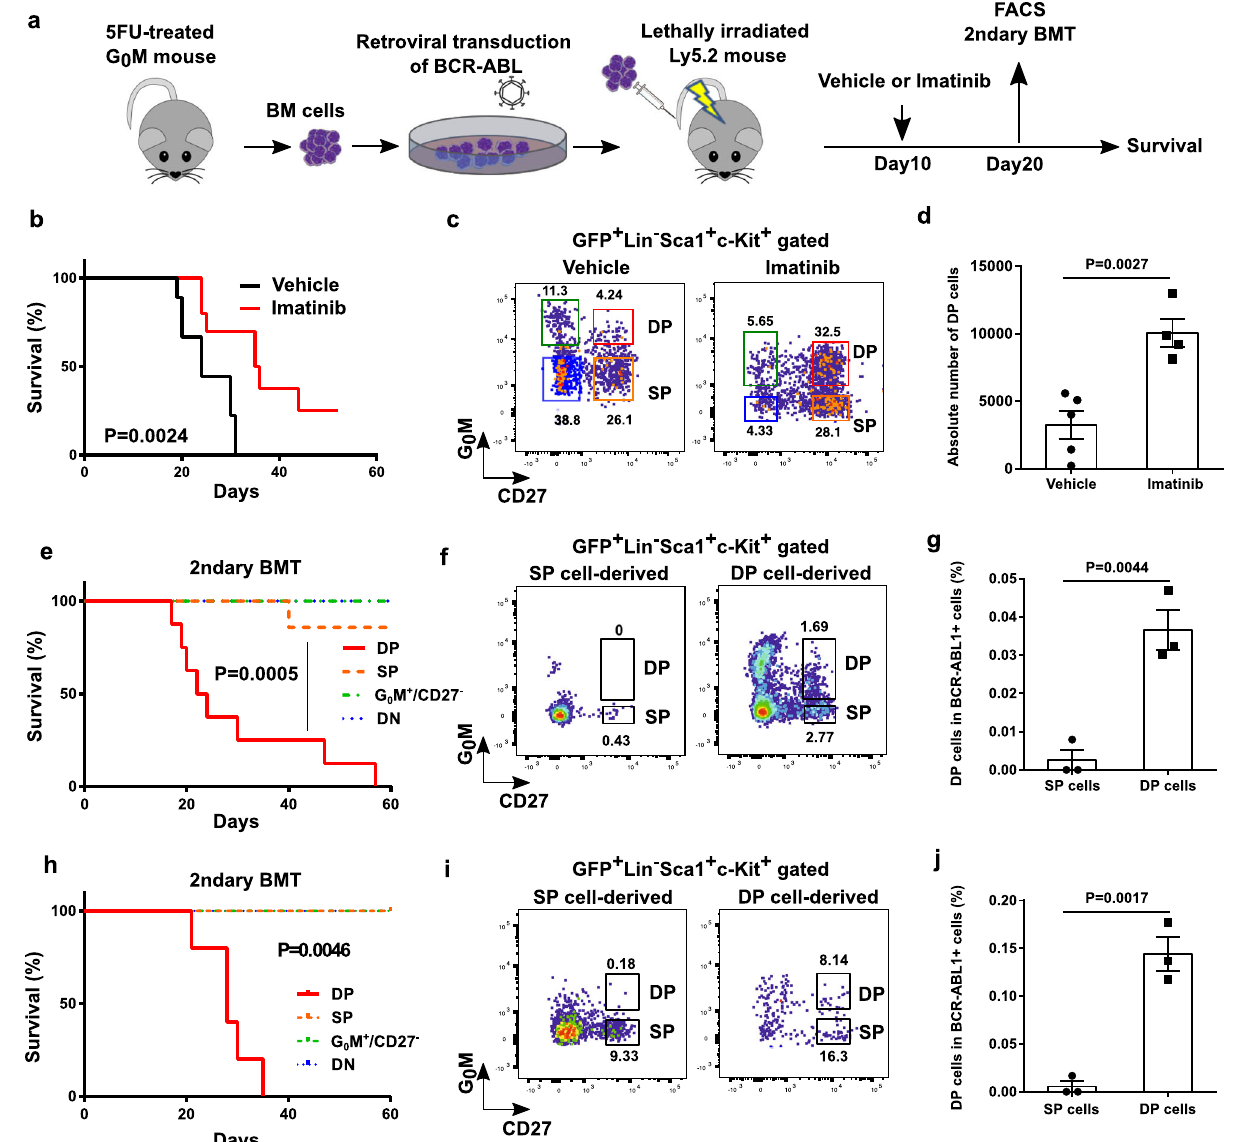
Fig. 1 G 0 M and CD27 identify quiescent CML LSCs. a Experimental design. BMT: bone marrow transplantation. b Survival curves for mice treated with vehicle ( n = 9) and imatinib ( n = 11). c Representative FACS plots of BCR-ABL1 + Lin - Sca1 + c-Kit + cells in the BM from mice treated with vehicle and imatinib. d Absolute number of LSCs (G 0 M + CD27 + cells in FACS plots in c ) in the BM from CML mice transplanted with SP cells ( n = 5) and DP cells ( n = 4). e Survival curves for recipient mice transplanted with the indicated populations from CML mice treated with vehicle. DP ( n = 8), SP ( n = 8), G 0 M + CD27 − ( n = 8), and DN ( n = 7). f Representative FACS plots of BCR-ABL1 + Lin − Sca1 + c-Kit + cells in the BM from the recipient mice transplanted with DP and SP cells in e . g The percentage of LSCs (G 0 M + CD27 + cells in FACS plots in F) in BCR-ABL1 + cells in the BM from CML mice transplanted with SP cells ( n = 3) and DP cells ( n = 3). h Survival curves for recipient mice transplanted with the indicated populations from CML mice treated with